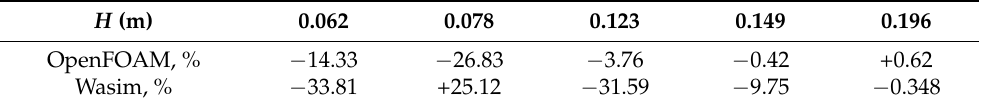
Table 9. Difference of numerical and experimental heave transfer functions for the KRISO containership.